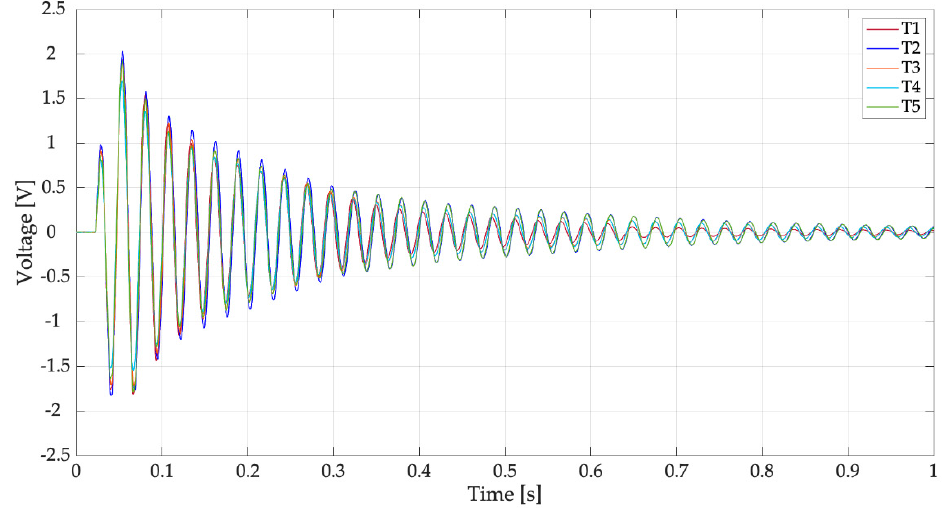
Figure 11. Tests with drops falling from 1 m on the filled spoon, open-circuit voltage.